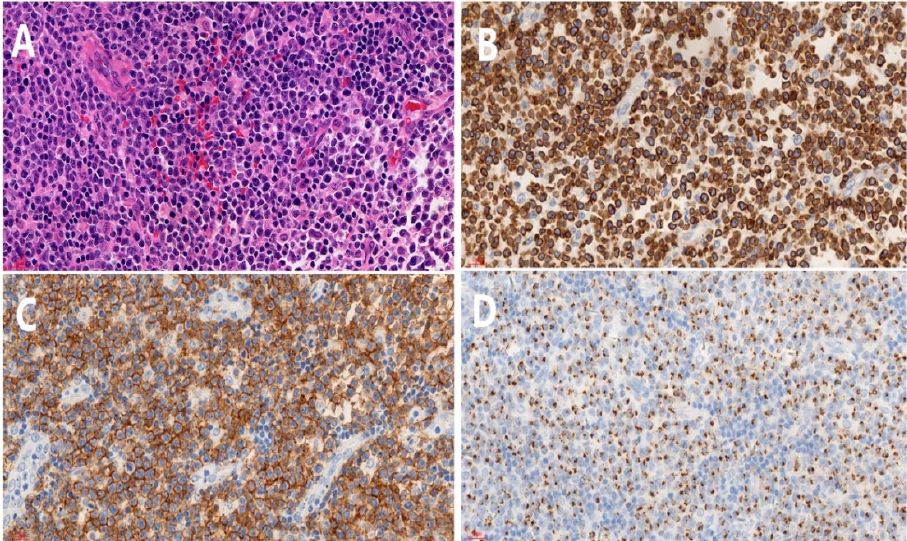
Figure 4. Histopathological examination of specimen ( A ) shows diffuse atypical lymphocyte infil- tration (H&E) (original magnification ×40). ( B ) shows staining for CD3 (original magnification ×40). ( C ) Staining for CD56 (original magnification ×40). ( D ) Staining for TIA-1 (original magnification ×40).